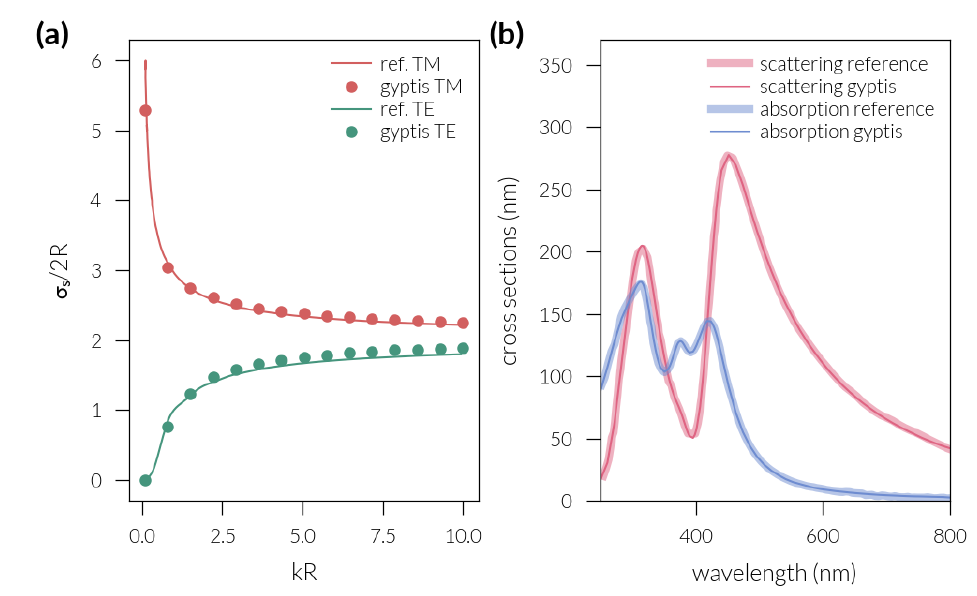
Figure A1. ( a ): Scattering cross-section (SCS) of a perfectly conducting cylinder for a TE (red) and TM (green) polarized plane wave as a function of kR ( k is the wavenumber and R the radius of the cylinder). Solid lines are results from [73] and markers are from our FEM implementation. ( b ): Scat- tering cross-section (SCS) and absorption cross-section (ACS) of a single silver-coated dielectric nanocylinder ( ε = 2). The inner radius is R 1 = 60 nm, outer radius R 2 = 30 nm. Wider lines are results from [74] and thin solid lines are from our FEM implementation.